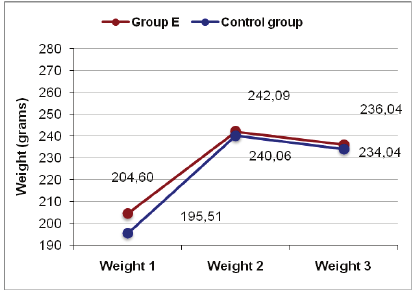
FIGURE 1 – Comparison between pondered variables for groups A, B, C, D, E and control